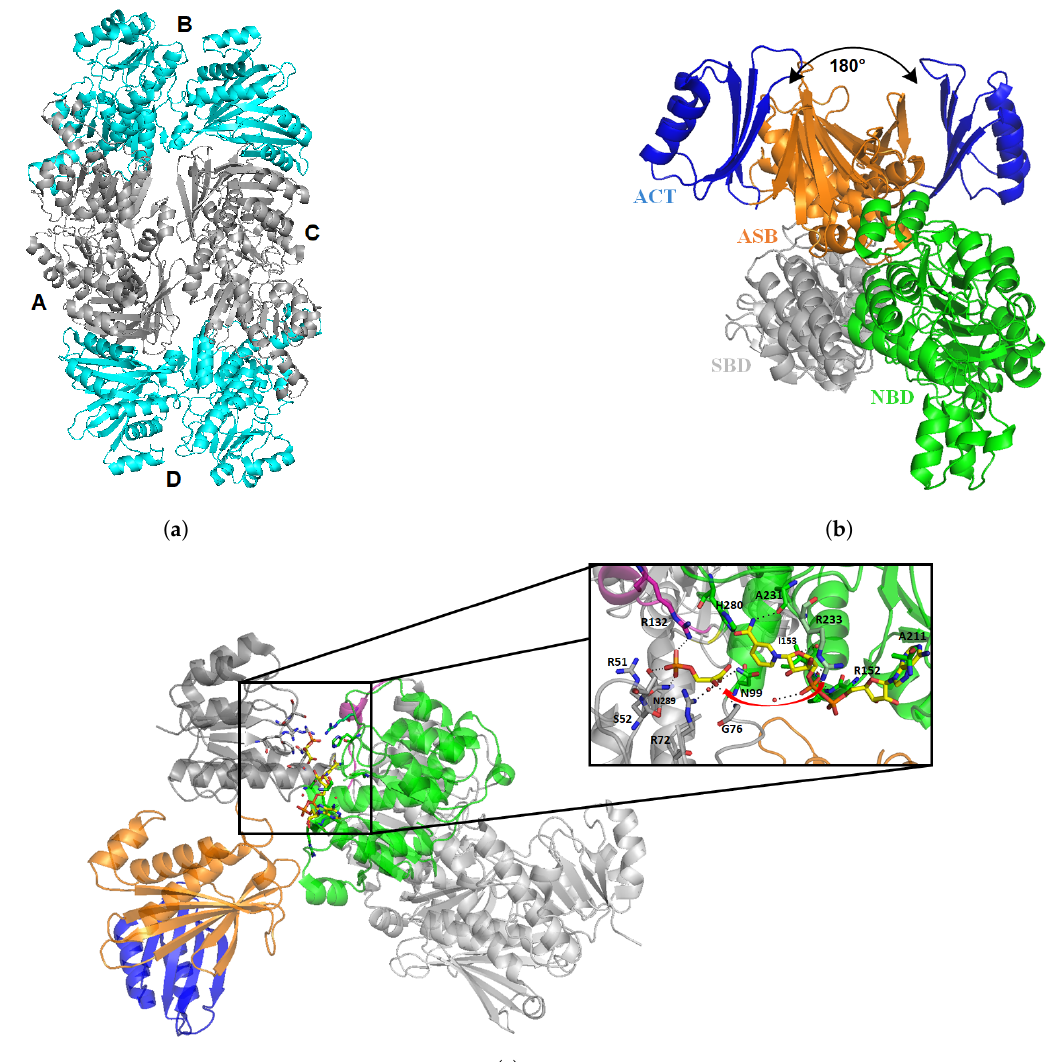
Figure 6. Structure of Mtb PHGDH (SerA1, 1YGY). The tetrameric form of SerA with two monomers in blue (B and D), and two 180 ◦ shifted monomers in grey (A and C) ( a ). View of one monomer ( b ) with domain ACT in blue, the Allosteric Substrate binding domain (ASB) in orange, the Substrate Binding domain (SBD) in grey, and the Nucleotide Binding domain (NBD) in green. Superimposition of both monomers shows a 180 ◦ rotation of ASB/ACT domain. Structure of SerA1 with the substrate 3-phosphohydroxypyruvate (PDB: 3DDN, ( c )) and generated NADH (from human PHGDH, 2G76) bound to SBD and NBD, respectively. An helix (in pink) from NBD from the other monomer is directly interacting with the substrate in